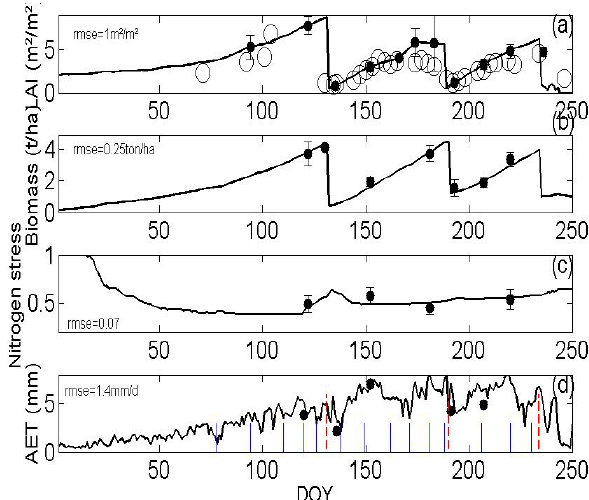
Figure 7 . Comparisons between STICS simulations and measurements performed on the reference field for the period: 1 January–30 September 2006 for: from top to bottom (a) LAI (m 2 /m 2 ) FORMOSAT and measurements (b) Biomass (ton/ha), (c) nitrogen stress index (d) AET (mm/d), computed in STICS according to the Shuttleworth and Wallace method. The red lines represent the cut dates and the blue lines, the irrigation dates.